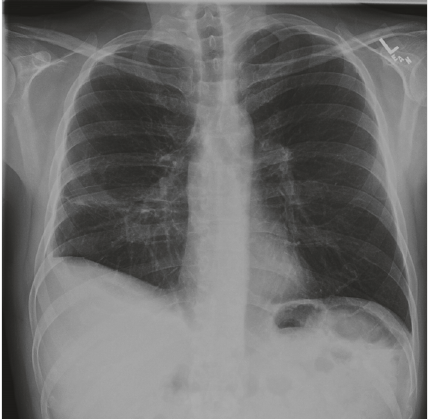
Figure 4: 4 months after hospital